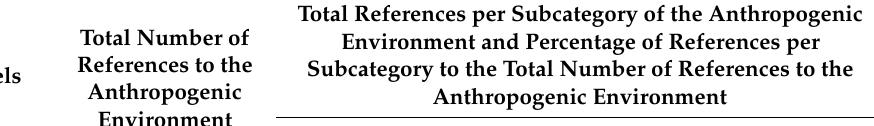
Table 8. Number of references to the anthropogenic environment.